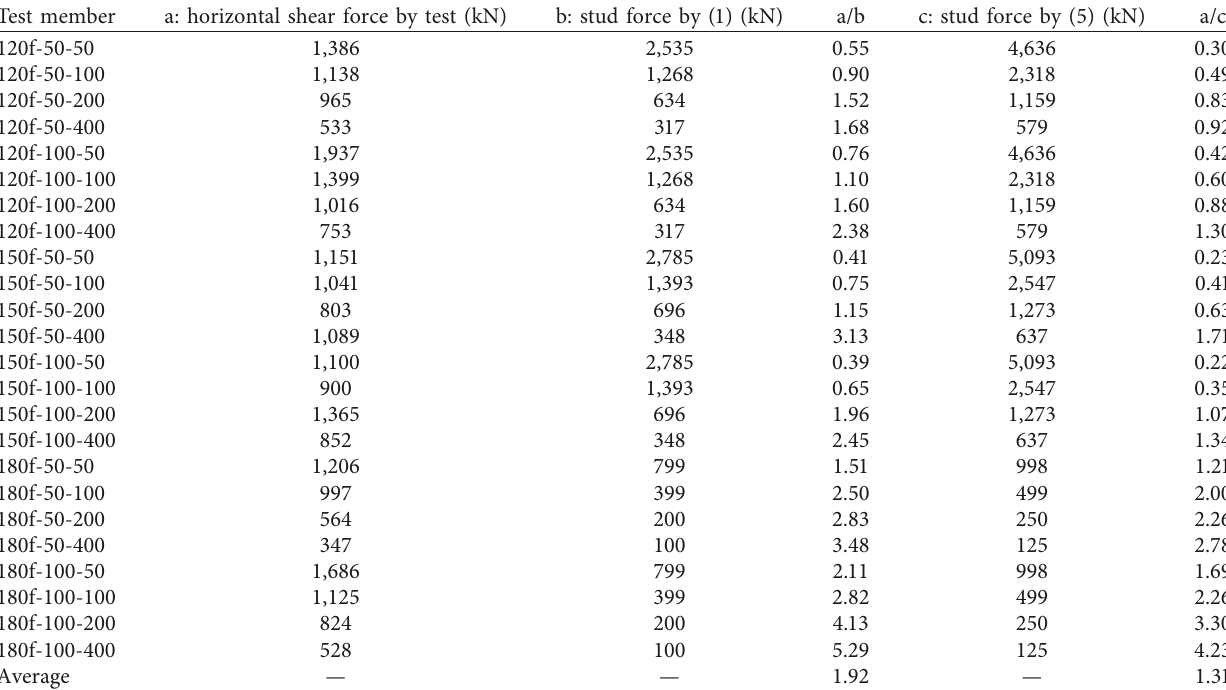
Table 5: Comparison of experimental ultimate horizontal shear force and predicted shear strength without safety factor. Test